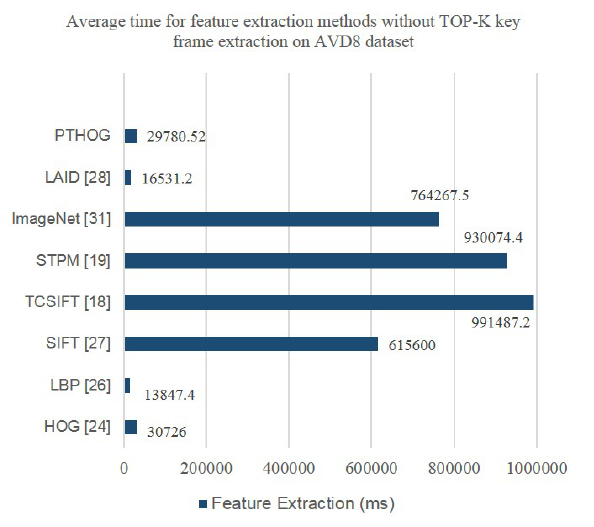
Figure 11. Average time for feature extraction methods without TOP-K key frame extraction on AVD8